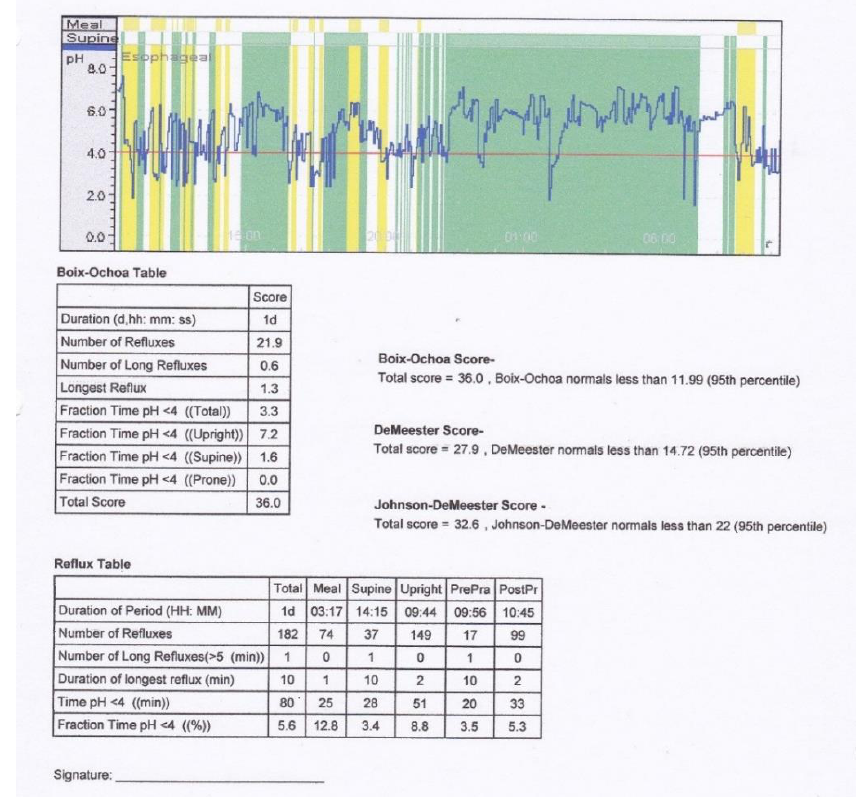
Figure 1. Positive pH-metry (from the clinic’s collection).